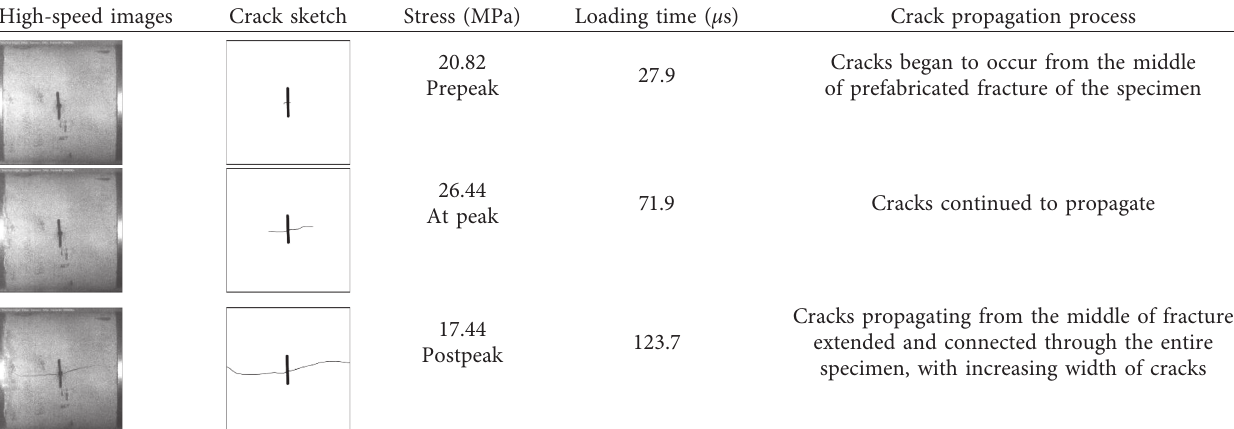
Table 2: Crack propagation process of Specimen c1 at the loading rate of